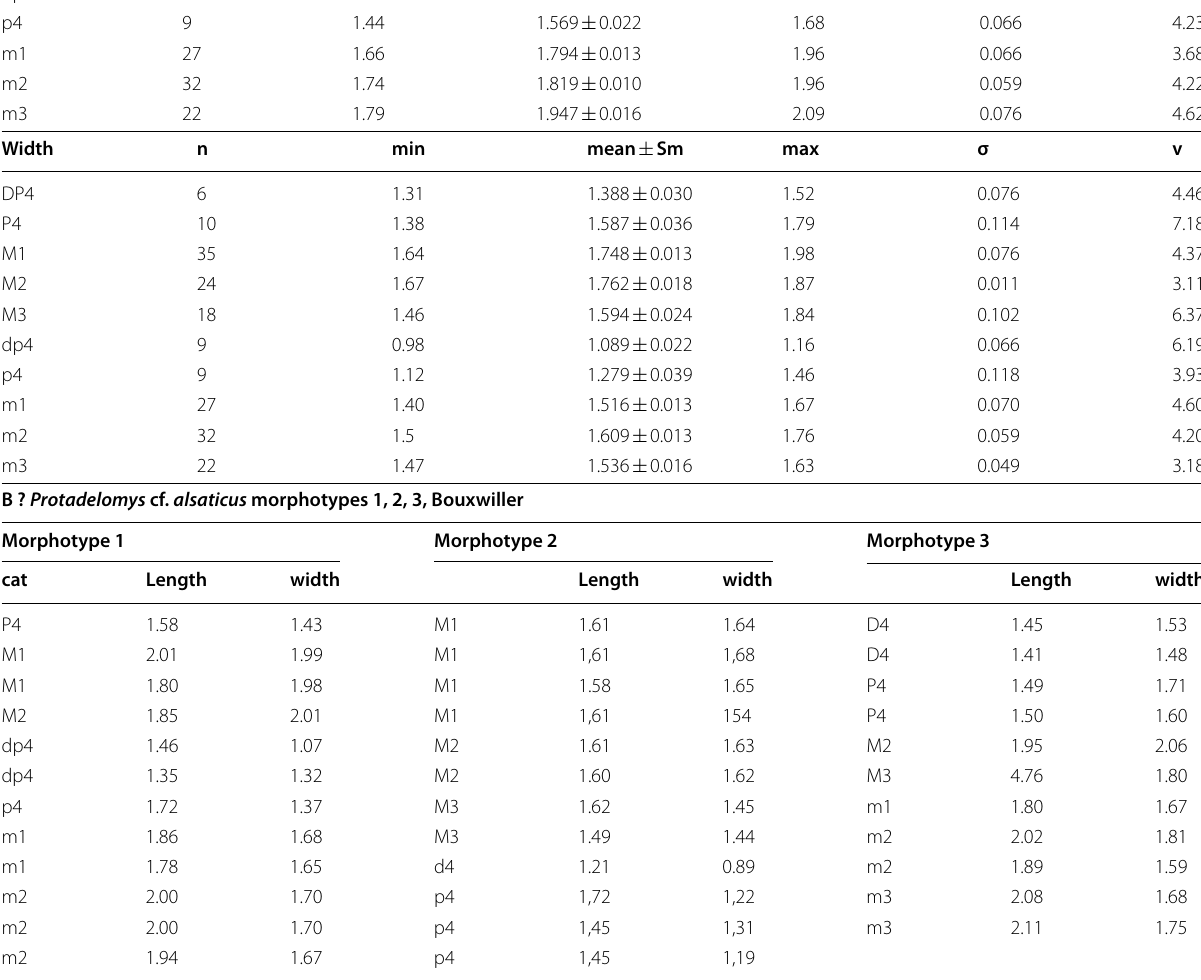
Sm σ/ √ n; v 100 σ/average L or W): A. of the different ± = =